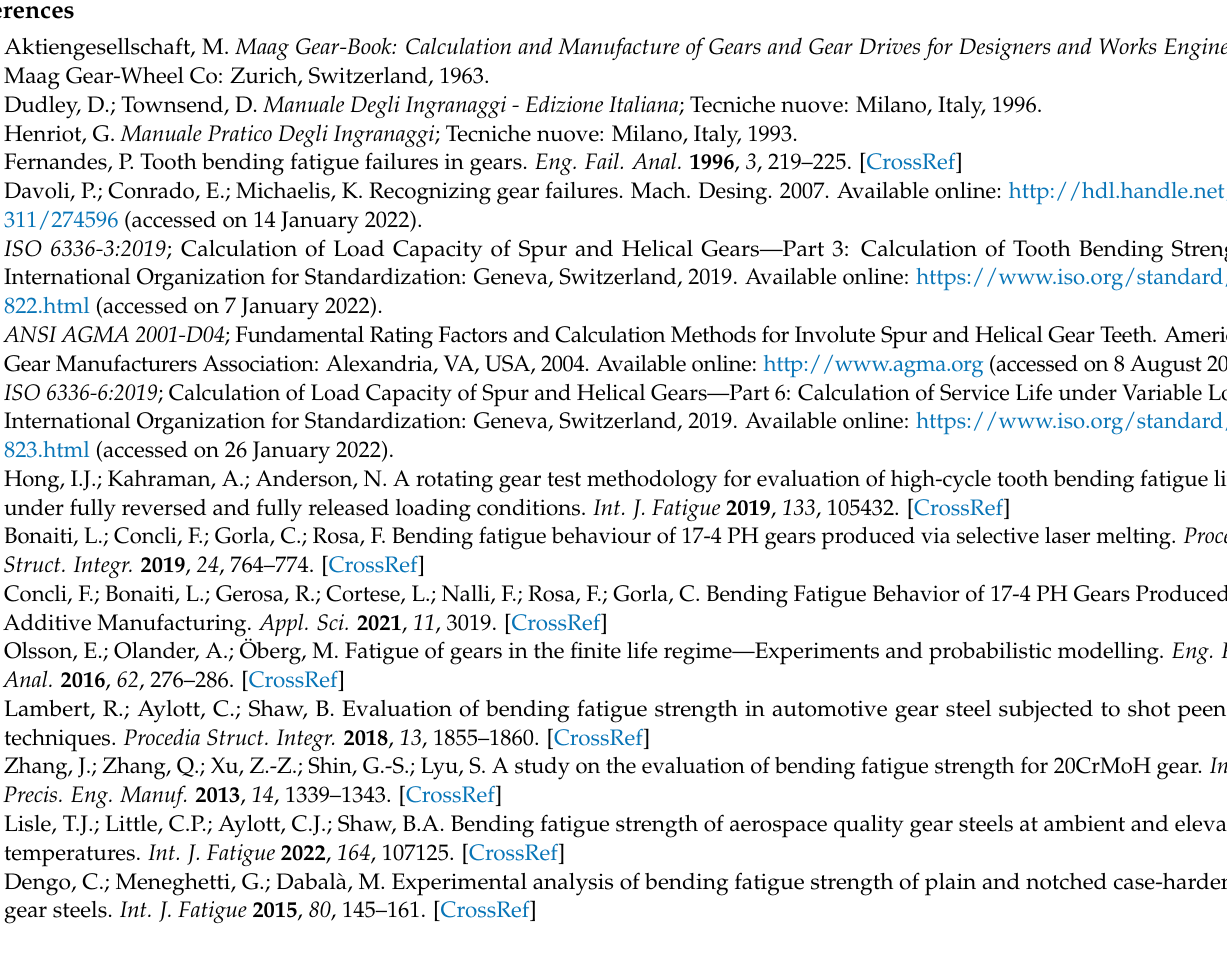
. F 0 ) 𝑠𝑠 𝑙𝑙𝑙𝑙𝑙𝑙 ( 𝜎𝜎 𝐹𝐹0 )